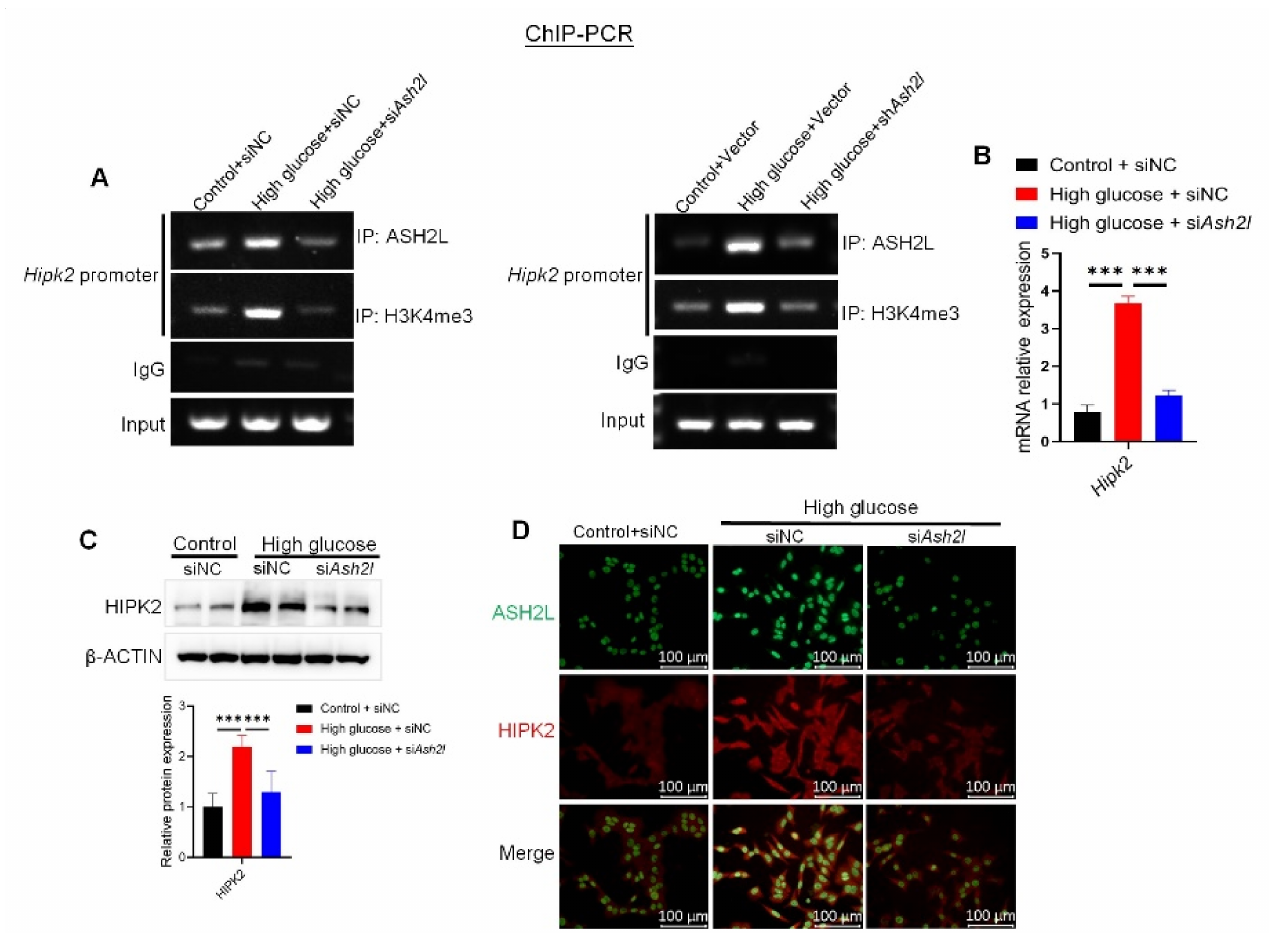
Figure 4. Loss of ASH2L suppresses HIPK2 expression in high glucose induced mesangial cells. ( A ) ChIP analysis of ASH2L binding to HIPK2 gene promoter in SV40-MES-13 cells. ( B ) Quantitative RT-PCR analyses of HIPK2 in SV40-MES-13 cells treated with or without 33 mM D-glucose for 24 h after transfection with negative control (siNC) or ASH2L small interfering RNA (si Ash2l ). Data are shown as mean ± S.D from at least three independent experiments with *** p < 0.001. ( C ) Western blot analysis of HIPK2 expression in SV40-MES-13 cells. Data are shown as mean ± S.D from at least three independent experiments and *** p < 0.001. ( D ) Immunofluorescence staining of ASH2L and HIPK2 in SV40-MES-13